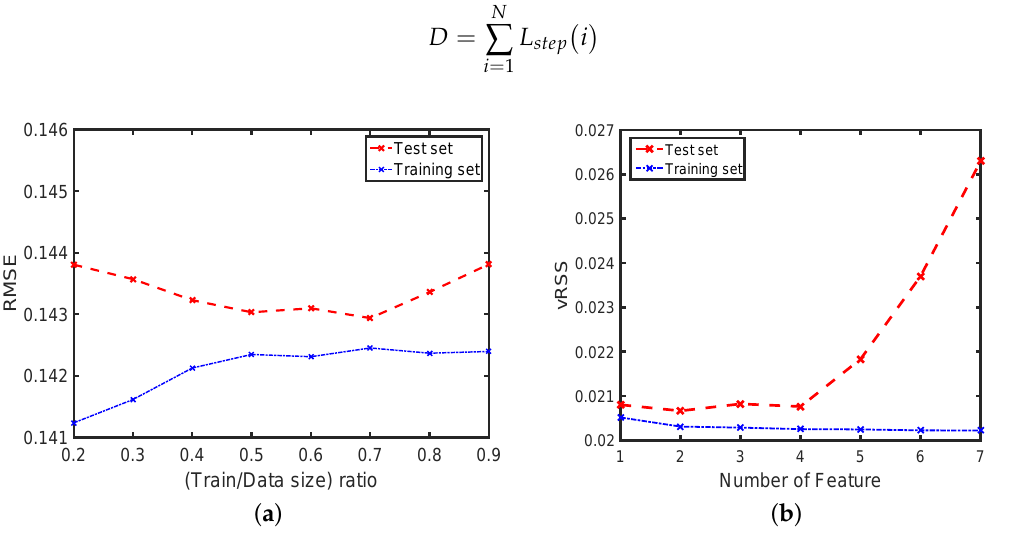
Figure 8. ( a ) RMSE of the actual and estimated velocities for training-set and test-set separation; ( b ) Variance of residual sum of squares (RSS) for degree decision of the polynomial